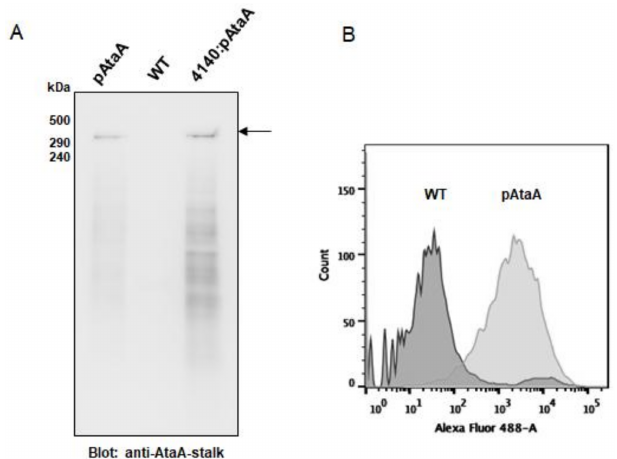
Figure 1. Expression and production of AtaA in Enterobacter aerogenes IAM1183. ( A ) Immunoblotting of outer membrane proteins prepared from the wild-type E. aerogenes IAM1183 (middle lane) and the cells transformed with the pAtaA construct (left lane) or Tol 5 4140::pAtaA (positive control, right lane). Arrow points to the detected band of the full-length AtaA protein. ( B ) Flow cytometry analysis for confirming surface display of AtaA on the transformant.